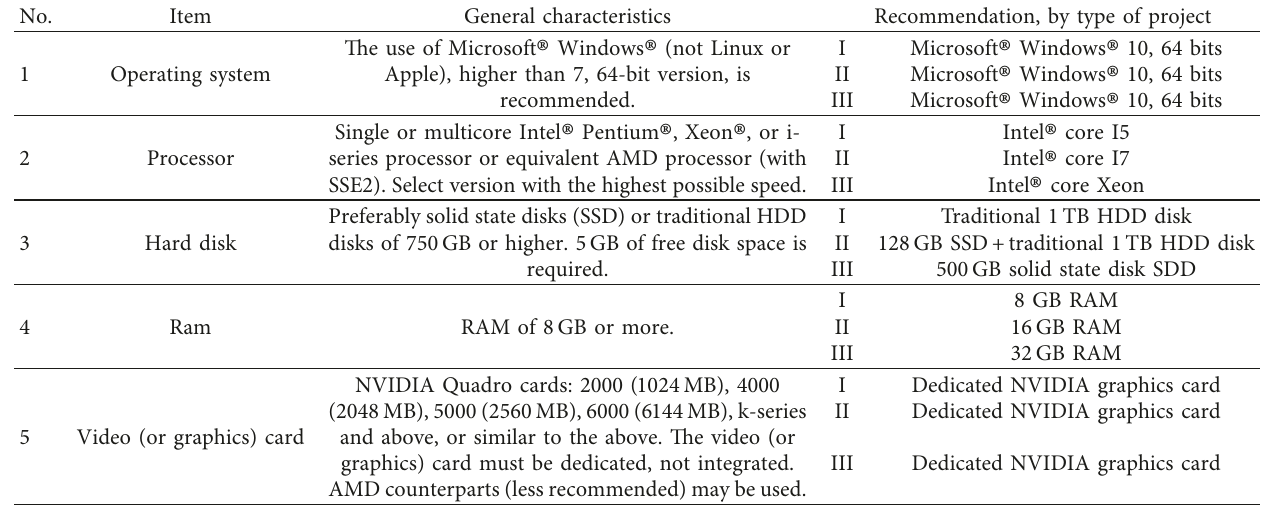
Table 5: Hardware recommendations for use of BIM software as of